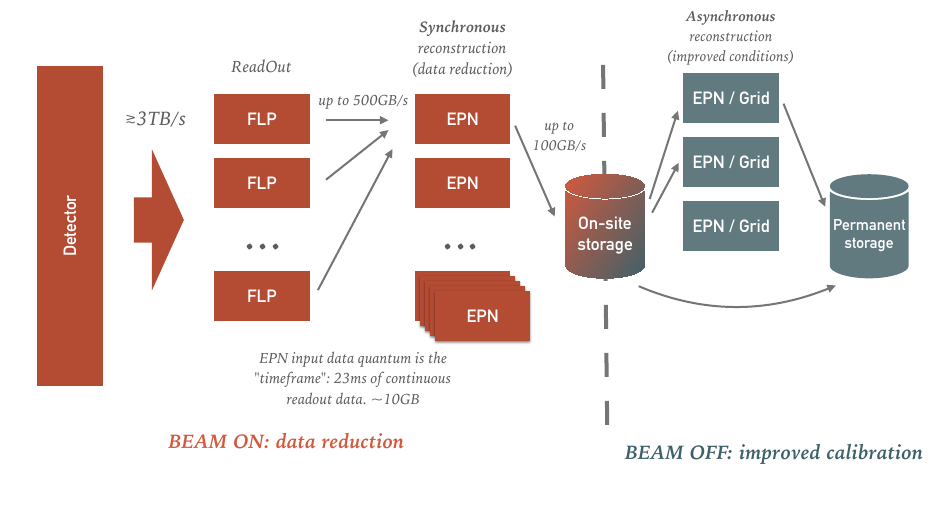
Figure 1. The Computing architecture of ALICE in Run